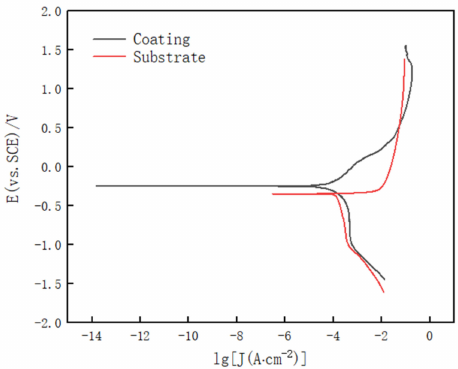
Figure 7. Tafel polarization curve of the 27SiMn substrate and Fe-based alloy cladding layer in 3.5% NaCl solution.